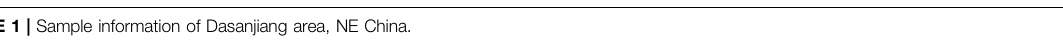
TABLE 1 | Sample information of Dasanjiang area, NE